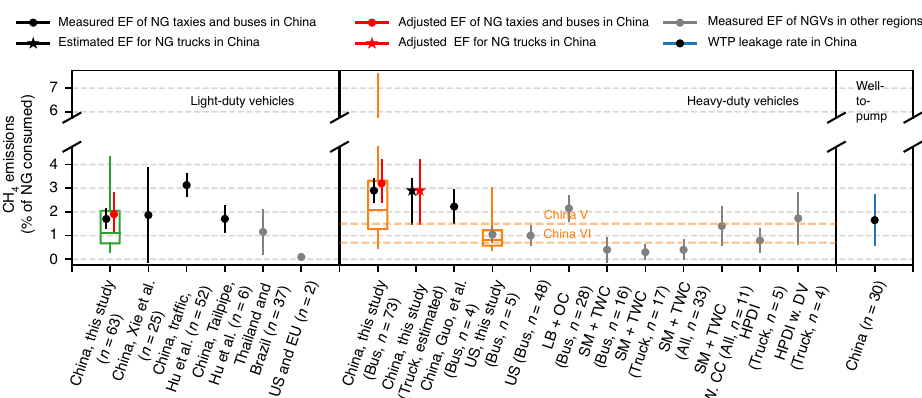
Fig. 2 Fuel-speci fi c emission factors as % of NG consumed for light-duty natural gas vehicles, heavy-duty natural gas vehicles, and fuel-speci fi c well- to-pump (WTP) NG leakage rate. The boxes and whiskers for our observations show 5th, 25th, 50th, 75th, and 95th percentiles of the observed EFs. Black dots and bars show the average values and standard errors of corresponding EFs measured in China. Black dots and bars show the average values and standard deviation (S.D.) of corresponding EFs measured in China. Numbers of independent samples (vehicles) used to derive EFs and the standard errors are listed in the labels. Red dots and bars show the venting-emission and seasonality adjusted values of corresponding EFs for China. Gray dots and bars show the average values and standard errors of corresponding EFs measured in other regions. The star and the associated bar show the estimated EF and its uncertainty for heavy-duty NG trucks equipped with a lean-burn engine and oxidation catalyst (determination of the uncertainty can be found in method section). Xie et al. and Guo et al. measured total hydrocarbon (THC) emissions instead of CH 4 23,52 . We converted their results to CH 4 emissions assuming 90% of THC is CH 4 as suggested by Xie et al. and Hu et al. 23,52 . The observed EF for heavy-duty vehicles is 85% higher than the current standard (China V). “ LB + OC ” , “ SM + TWC ” , “ SM + TWC w. CC ” , “ HPDI ” , and “ HPDI w. DV ” stand for a lean-burn engine with oxidation catalyst, stoichiometric engine with three-way catalyst, stoichiometric engine with a three-way catalyst with crankcase emissions, high-pressure direct injection (HPDI), and HPDI with dynamic venting emissions. Source data are provided as a Source Data fi